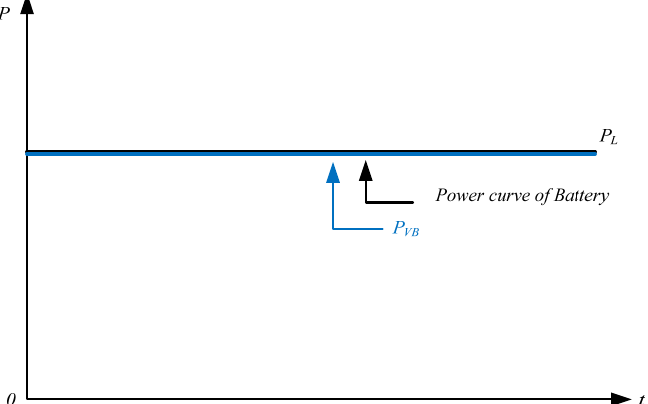
Figure 8. Plot of power curve of the proposed PV power system under operational mode